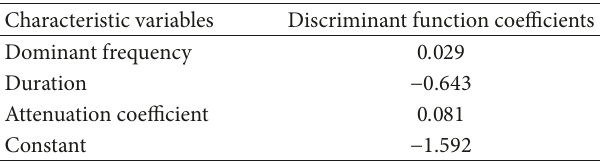
Table 4: Discriminant function coefficients of two types of